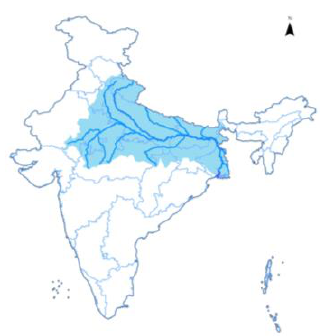
Figure 1. Study area of Ganga River